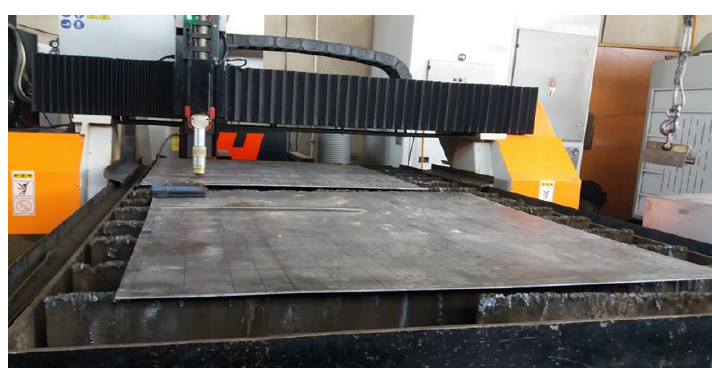
Figure 7. Creating holes in plates using CNC machines.